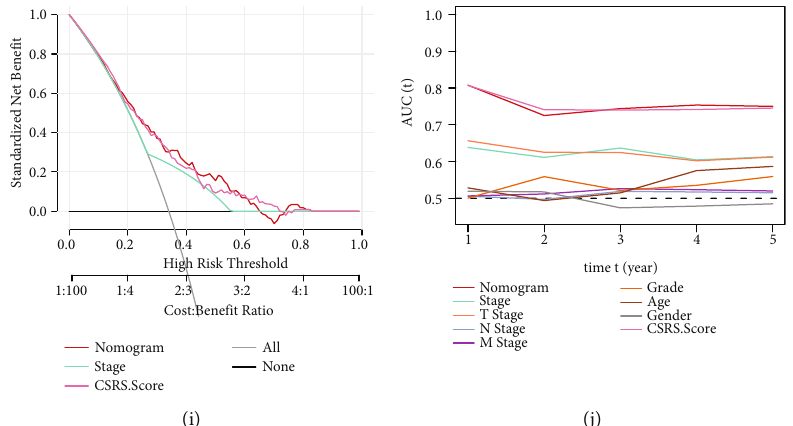
Figure 7: Risk-score model adjustment based on clinical features. (a) The decision tree was constructed according to age, sex, disease stage, T stage, grade, and CSRS. Score of HCC patients in the TCGA-LIHC cohort. (b) Overall survival time curve between subgroups based on decision tree (low, mediate, high, and highest). (c) Comparisons of CSCR score-based risk score subgroup and decision tree-based subgroup classi fi cation (low, mediate, high, and highest). (d) Comparisons of di ff erently expressed genes identi fi ed in subgroups and decision tree classi fi cation (low, mediate, high, and highest). (e and f) Univariate and multivariate Cox analyses of CSRS and clinicopathological features. (g) Line diagram model. (h) Calibration curves for 1, 3, and 5 years of the row diagram. (i) Decision curve of the line graph. (j) Comparison with other clinicopathological features. *P < 0.05; **P < 0.01; ***P <